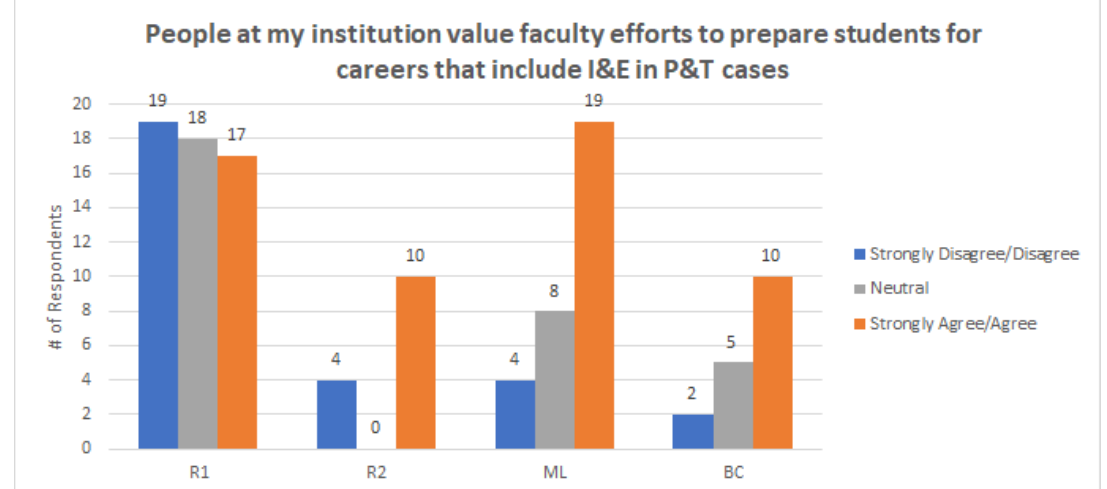
Figure 6. Comparison of institution type responses related to how people at their institution value in P&T cases faculty efforts to prepare students for careers that include